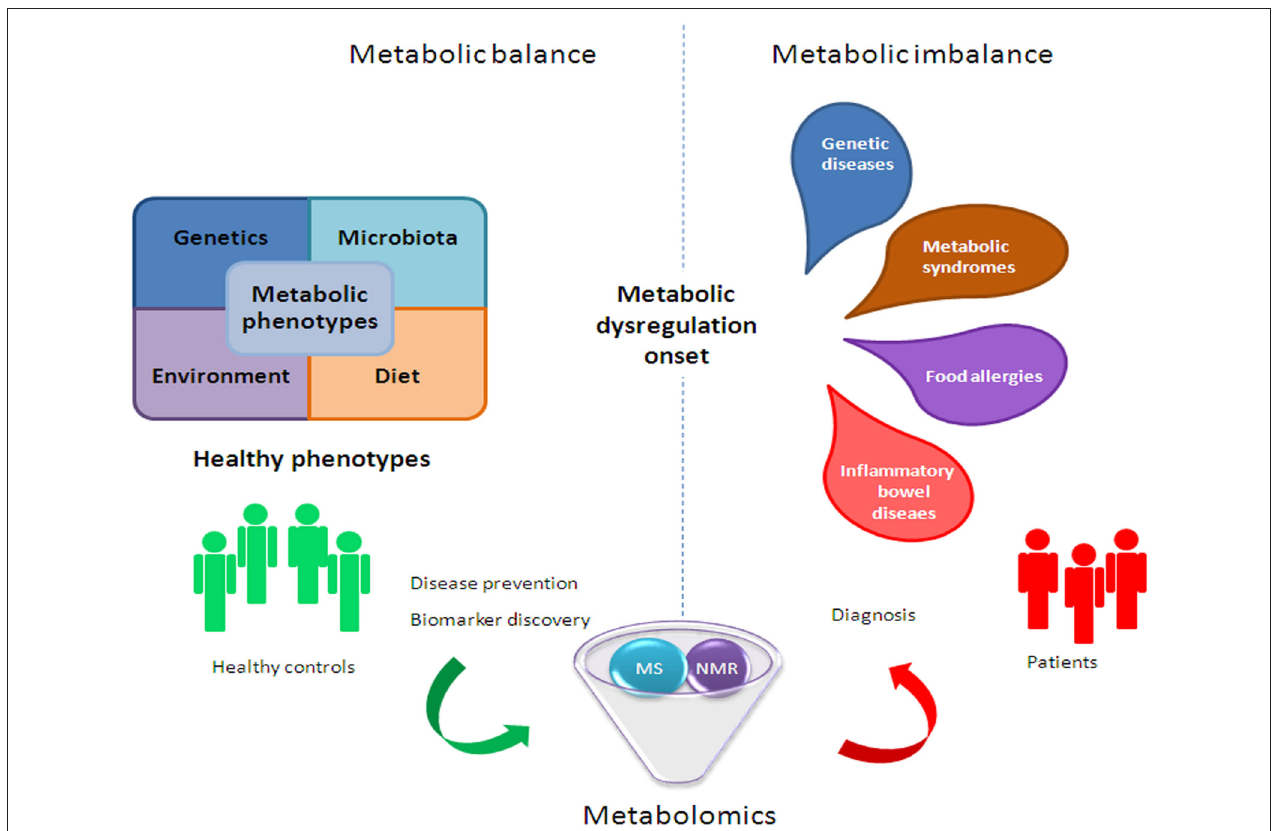
FIGURE 2 | Metabolomic application in human health to improve clinical and nutritional settings.